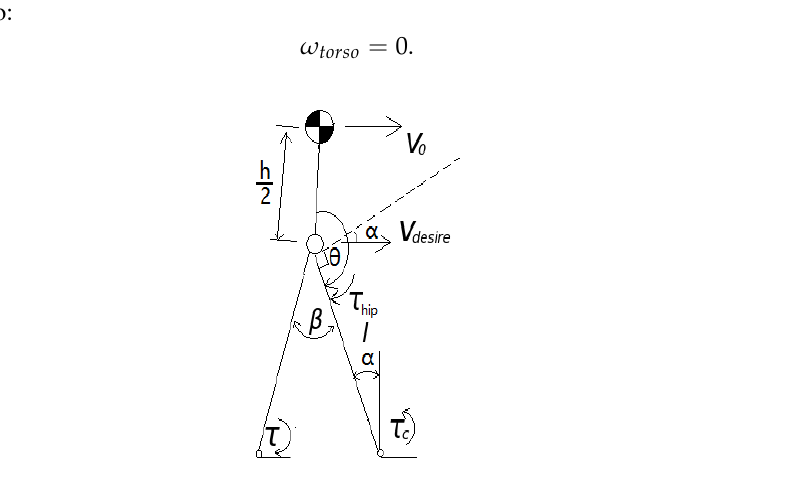
Figure 8. Model of biped with torques applied about ankle and